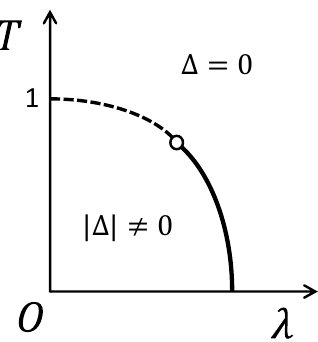
Figure 20 . Sketch of the phase diagram of the toy model for M = 2 . The solid curve denotes a first-order phase transition and the dashed curve a second-order phase transition. The open circle marks a tri-critical point whose exact location is given by (A.40) at T = 1 − γ 1 / 6